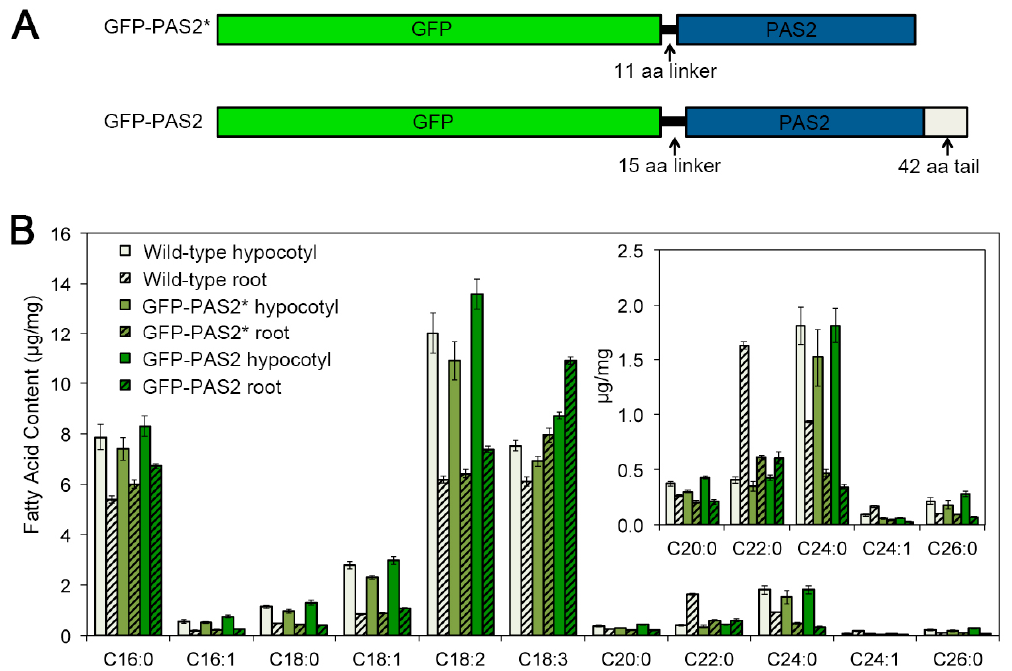
Figure 8. Comparison between the GFP-PAS2 transgenic line generated in this study (GFP-PAS2) and that generated by Bach et.al (GFP-PAS2*). ( A ). Schematic graphs showing two different